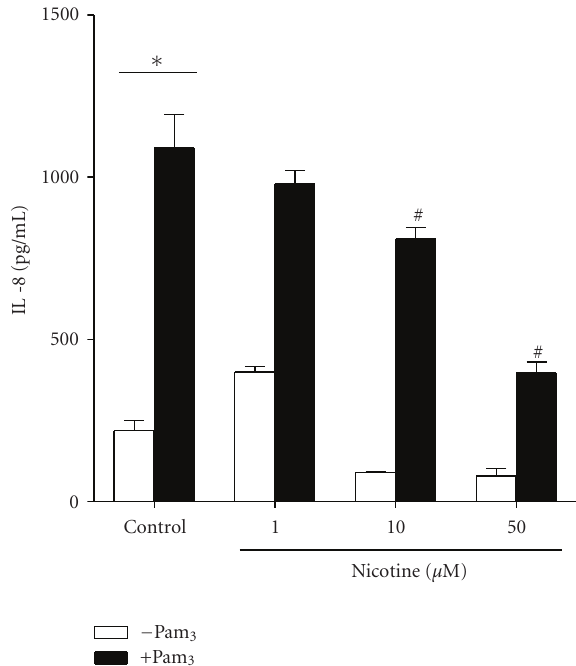
Figure 3: Nicotine inhibits Pam 3 -induced IL-8 production in a dose- dependent manner. CFTE29o- cells (1 × 10 5 /mL) were left untreated or stimulated with increasing doses of nicotine (0–50 μ M) for 1 hour then left untreated or stimulated with Pam 3 (1 μ g/mL, 24 hours) as indicated. Levels of IL-8 in supernatants were measured by ELISA and values are expressed in pg/mL ( ∗ and # P ≤ . 05, ∗ versus control, # versus Pam 3 ). Assays were performed in triplicate ( n =